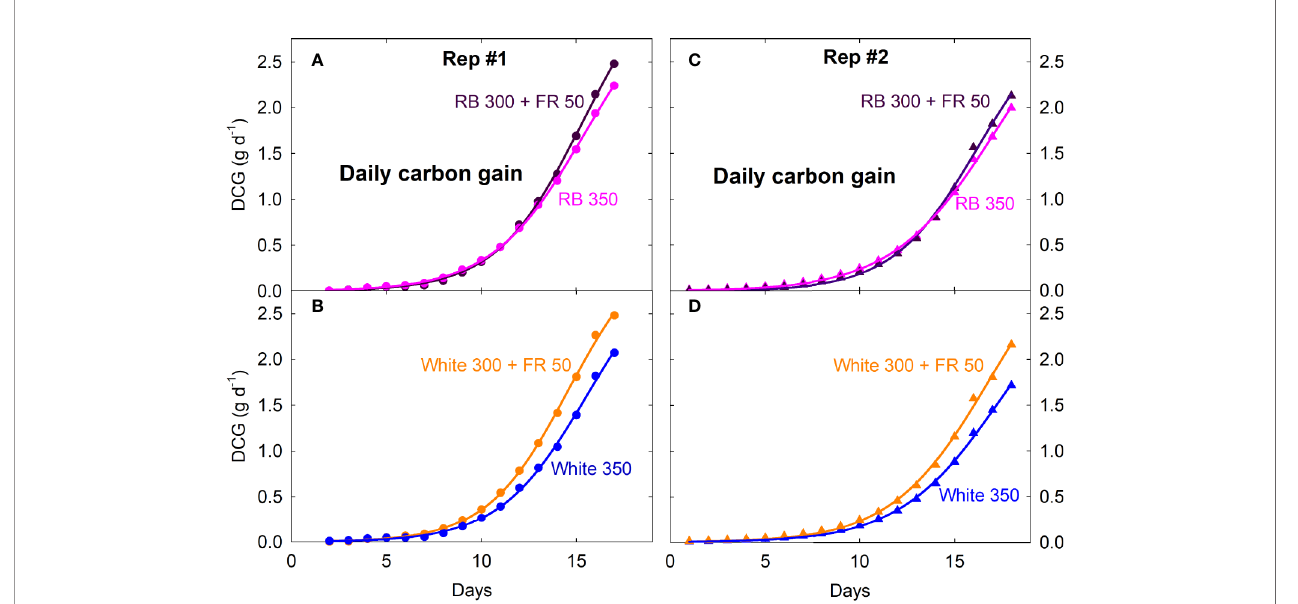
FIGURE 3 | Daily carbon gain (DCG, a measure of canopy growth rate) of lettuce under four spectral treatments from seedling to mature plants. RB, red and blue; FR, far-red. The numbers following each type of light ( e.g . RB 350) indicate photon fl ux density in m mol m − 2 s − 1 . Plants were moved into the gas exchange system from a greenhouse on day zero (four days after emergence in Rep 1 and two days after emergence in Rep